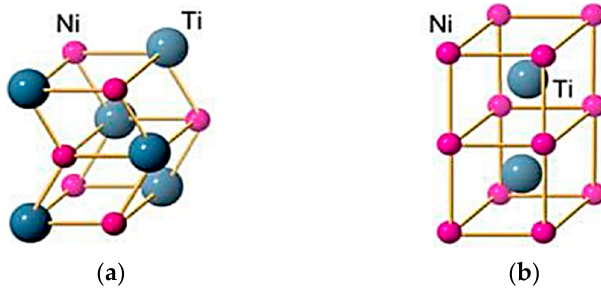
Figure 1. Crystal structure phases of NiTi showing ( a ) B19 ′ martensite, and ( b ) B2 austenite [3].